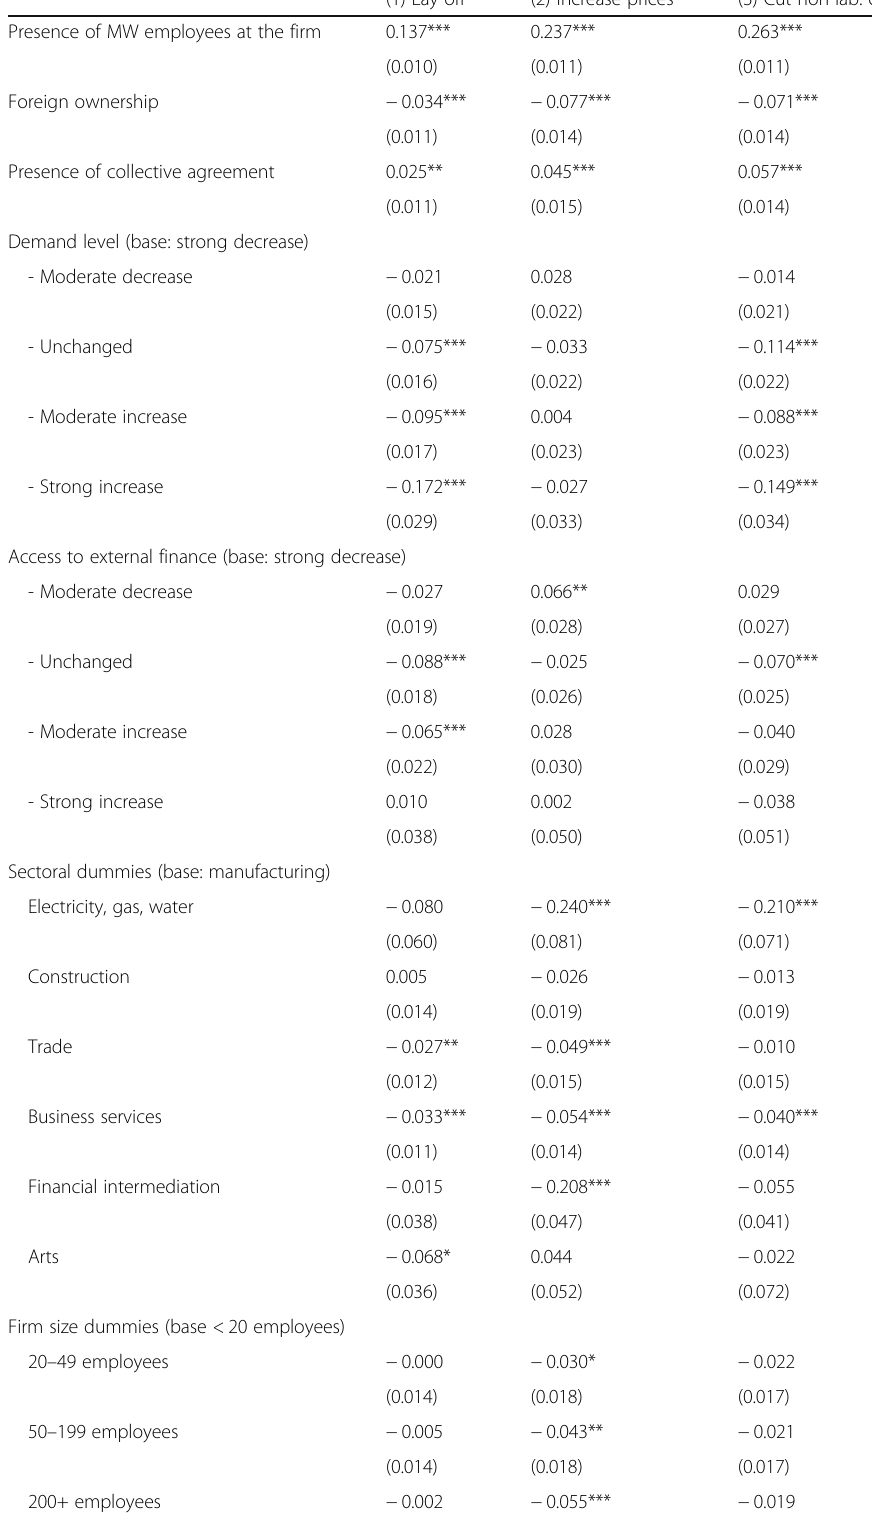
Table 6 Multivariate probit model of the relevance of adjustment channels, average marginal effects (all countries; 3 adjustment